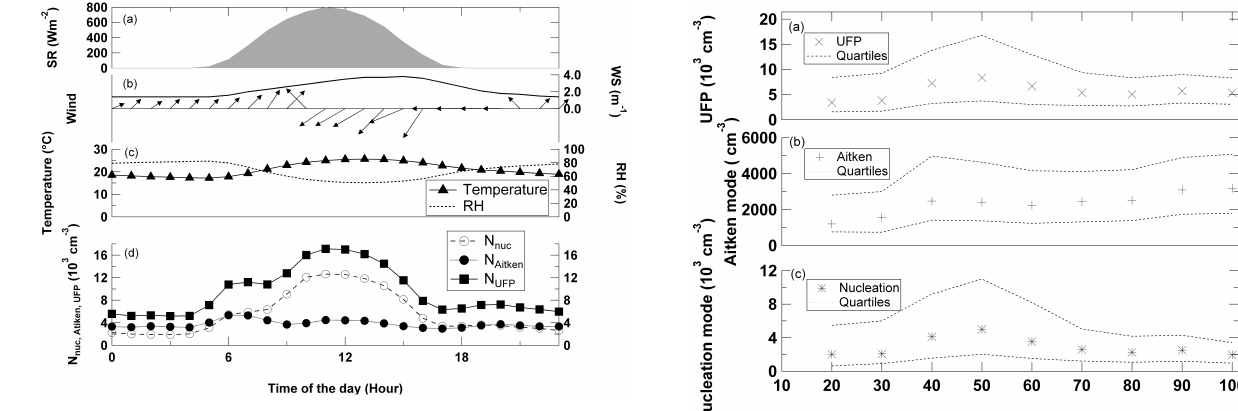
Fig. 5. Number concentrations of (a) ultrafine (UFP), (b) Aitken mode and (c) nucleation mode particles and their variation as a function of relative humidity. The median number concentrations and the 1st and 3rd quartiles are